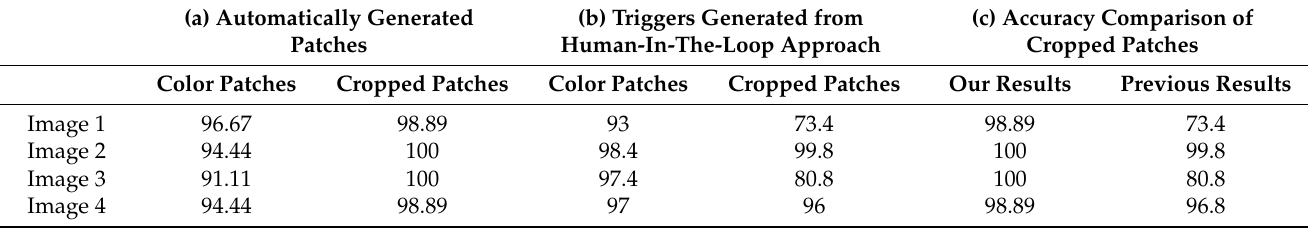
Table 1. Comparison of human-in-the-loop technique and our automatic technique for attack success